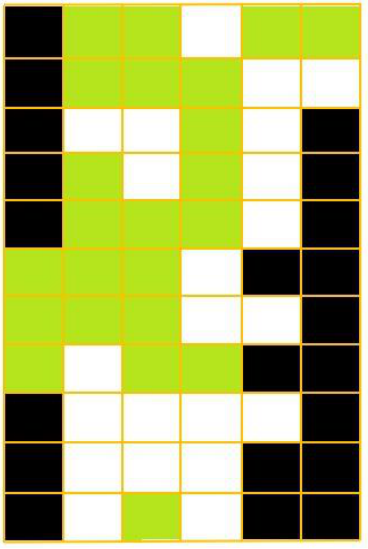
Figure 1. ( a ) Portuguese mainland counties where termite presence was reported until 1970. The counties represented in yellow are the ones where observations existed, whereas the ones in grey are the ones where no termites were reported until 1970. ( b ) Portuguese mainland divided into a 11x6 grid, where each resulting cell has a 50 × 50 km dimension.